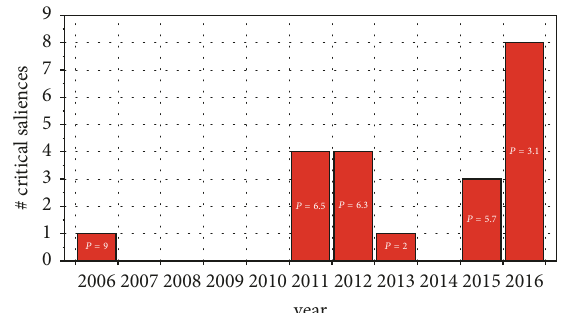
Figure 2: Number of critical saliences per year. In each bar the average of 𝑃 events occurring is presented. 𝑃 = [ Magnitude × Intensity ] , both on a scale of 1 to 3, where 1 is low, 2 is medium, and 3 is high. Magnitude is measured as the number of the saliences according to the territorial scope. Intensity is measured according to the number of people involved and associated